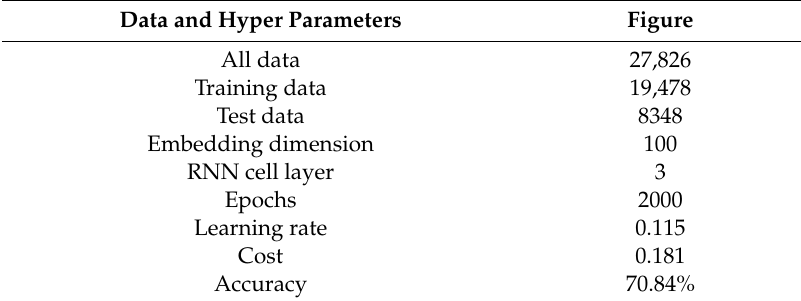
Table 3. Hyper parameters and result performance.